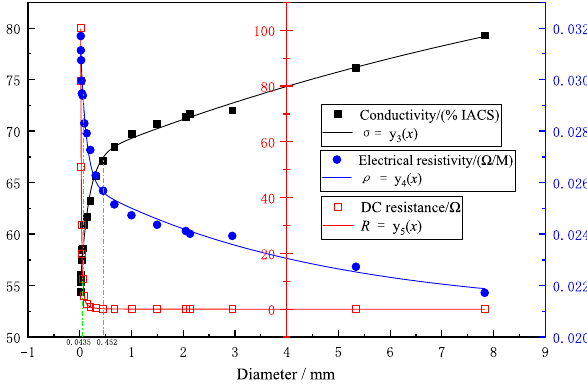
Figure 6: Electrical properties of as - drawn wires with di ff erent dia - meters during multi - pass